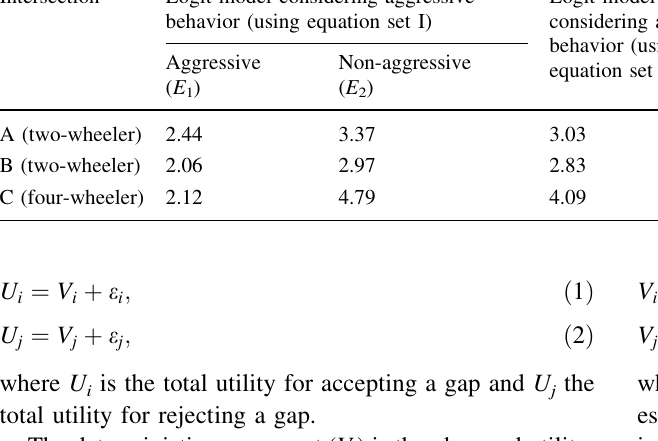
Logit model without considering aggressive